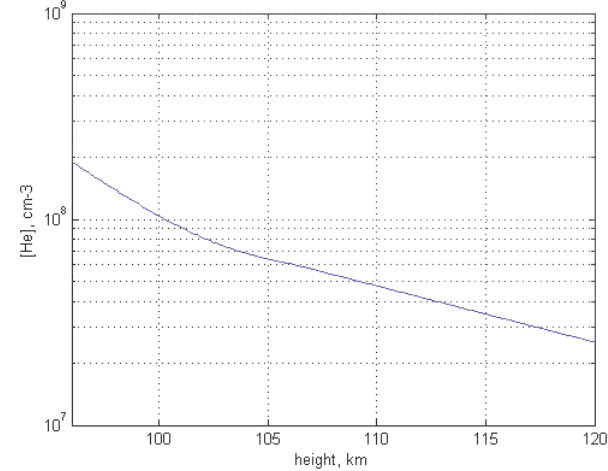
Fig. 5c. The same as in Fig. 5a but at the equator. = 3 × 10 6 cm 2 s − 1 , ed